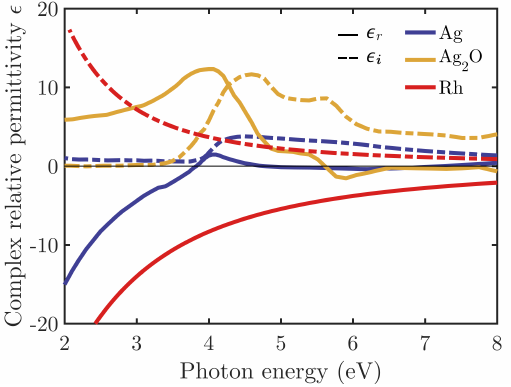
Figure 2. Real (solid line) and imaginary (dashed line) parts of the complex relative permittivity ( (cid:101) ) of Ag (blue), Ag 2 O (yellow) and Rh (red) as a function of the photon energy of the incident